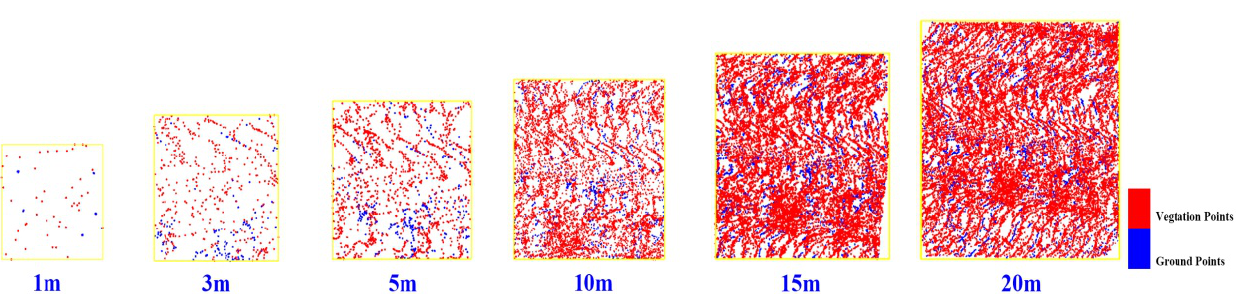
The distributions of ground and vegetation points (Figure 8) at different sampling resolutions were obtained according to the classification results in Section 2.3 (sampled at the exact center with expanded sides).